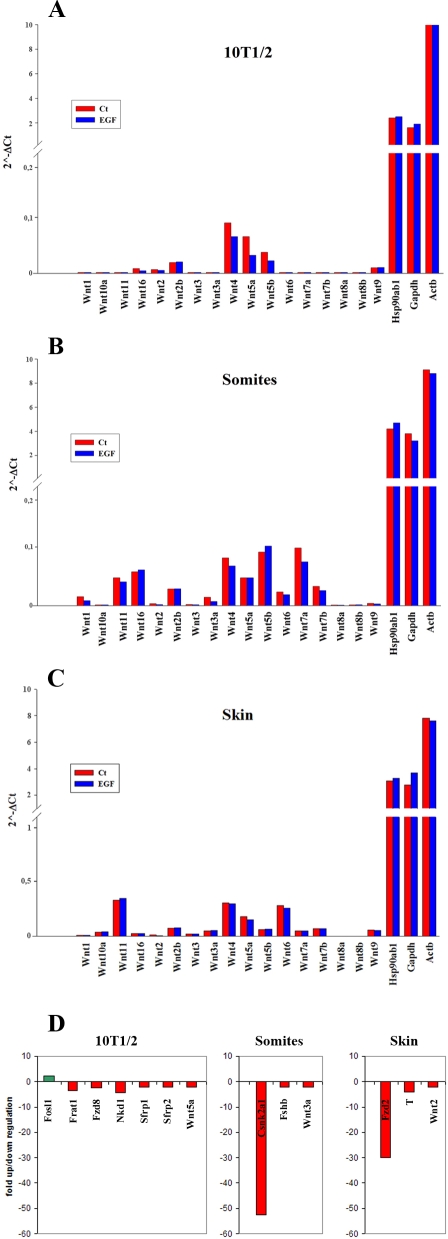
Wnts expression profile in C3H10T1/2 and embryonic explant cultures.Wnt genes expression in C3H10T1/2 fibroblast (panel A), somites (panel B) and embryonic skin (panel C). Histograms represent the relative expression level for each gene in control (red bars) and EGF-treated (blue bars) samples, as calculated with the 2ˆ (−Δ Ct) formula in comparison with the housekeeping genes Hsp90ab1, Gapdh and Actb (see Materials and Methods for details). (Panel D). EGF-modulated genes in C3H10T1/2 fibroblast, somites and embryonic skin. For genes description, see Table S2.